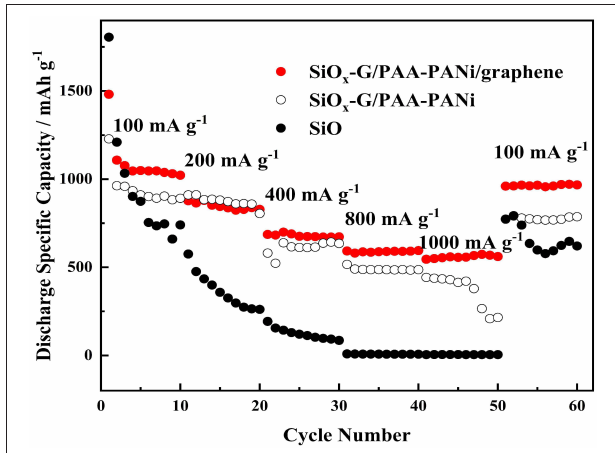
FIGURE 8 | The rate performances of SiO x -G/PAA-PANi/graphene, SiO x -G/PAA-PANi, and SiO electrodes.